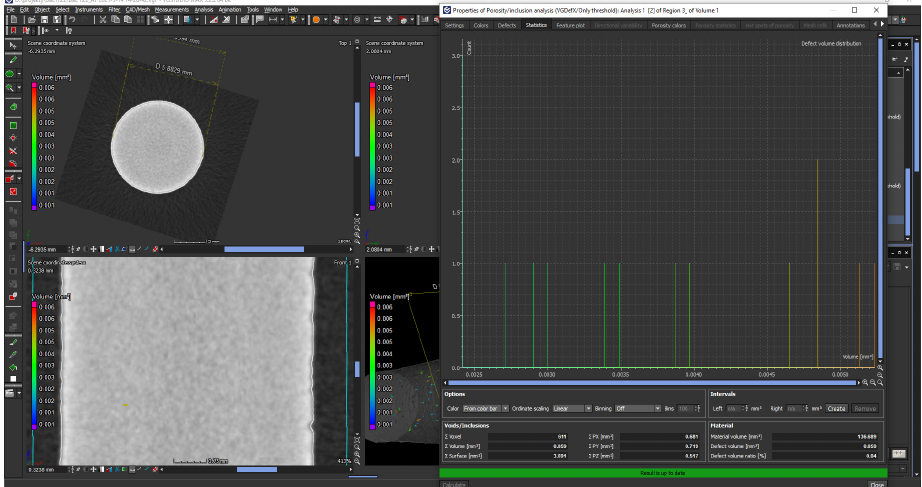
Figure 6. VGSTUDIO MAX 3.2 Porosity analysis of the sample.